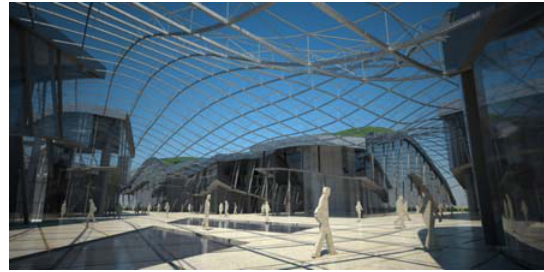
Figure 7. A rendered view of the designed exposition